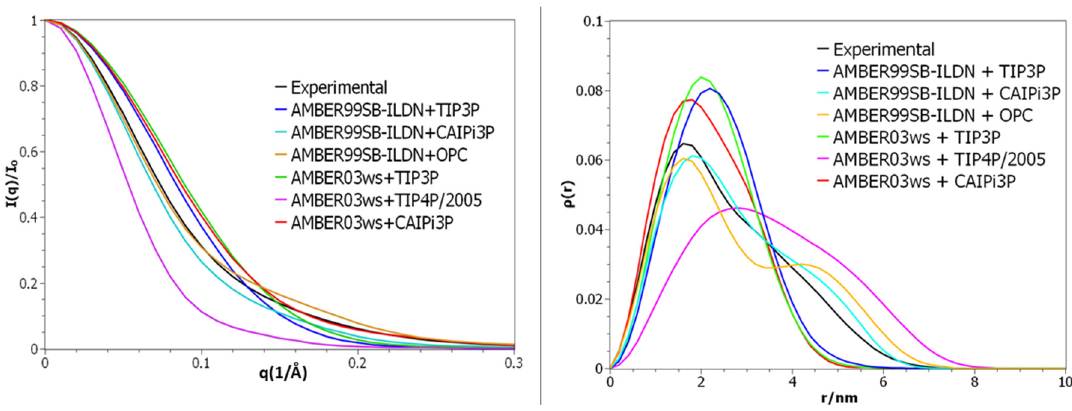
Figure 6. ( Left panel ) Small-angle X-ray scattering (SAXS) intensities. ( Right panel ) Pair distance distribution function for At2g23090